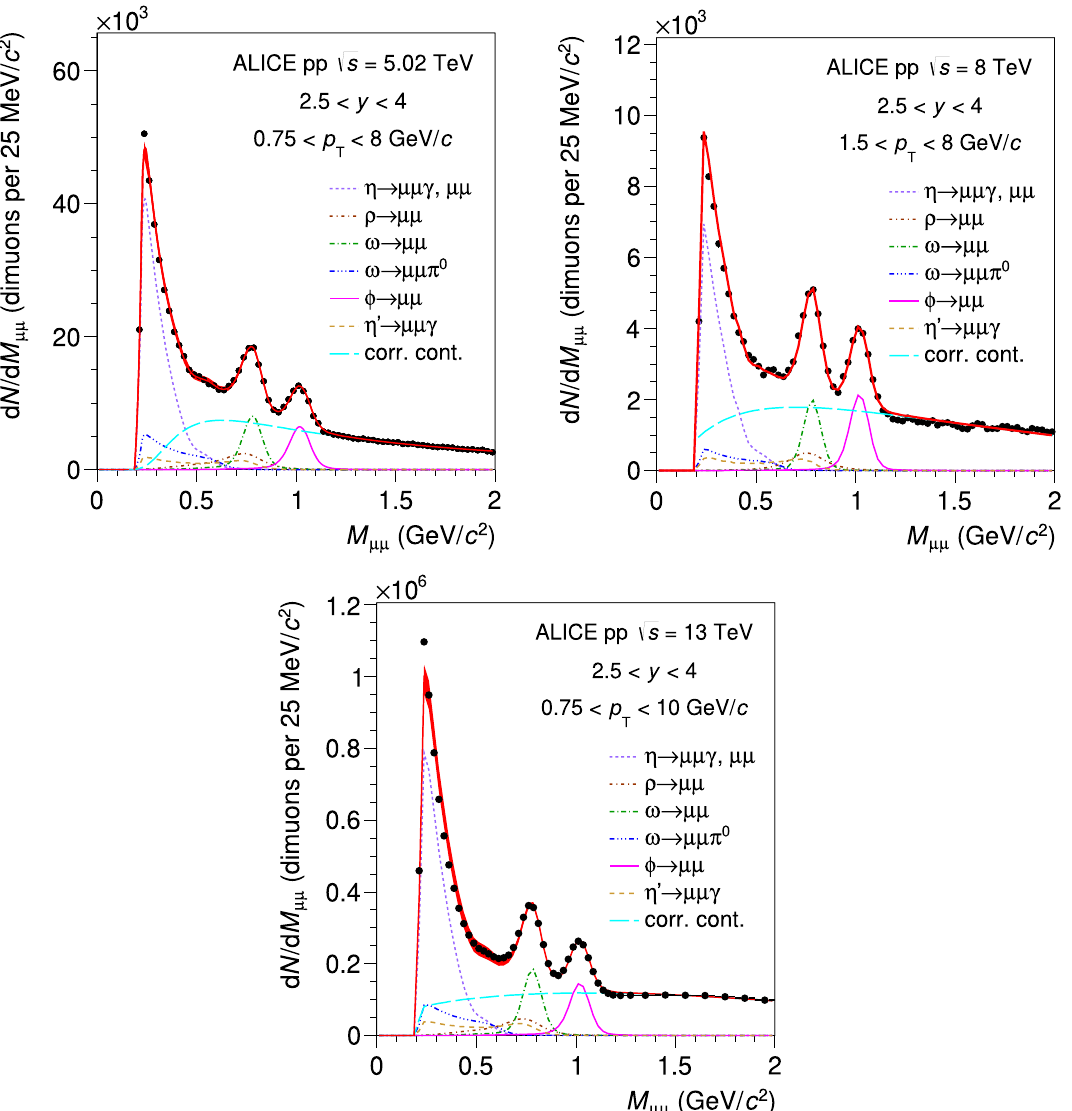
√ s = 5 . 02, 8 and 13 TeV, for muon pairs in